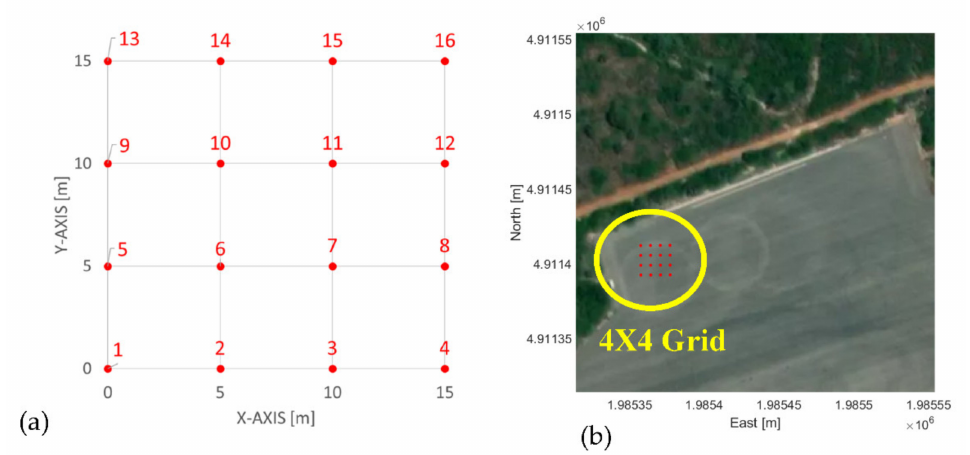
Figure 16. A 4 × 4 point grid defined in a Cartesian reference system ( a ); the same point grid defined in the Web Mercator coordinate system on the Mapbox satellite map of developed Matlab tool ( b